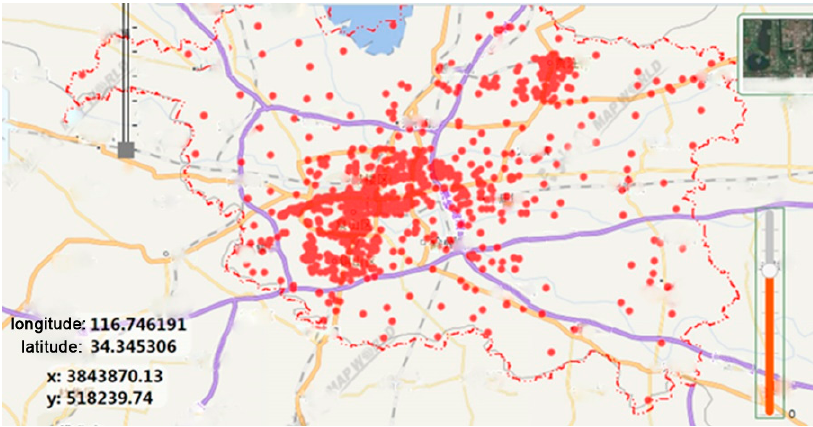
Figure 7. Distribution of the boreholes in the study area.